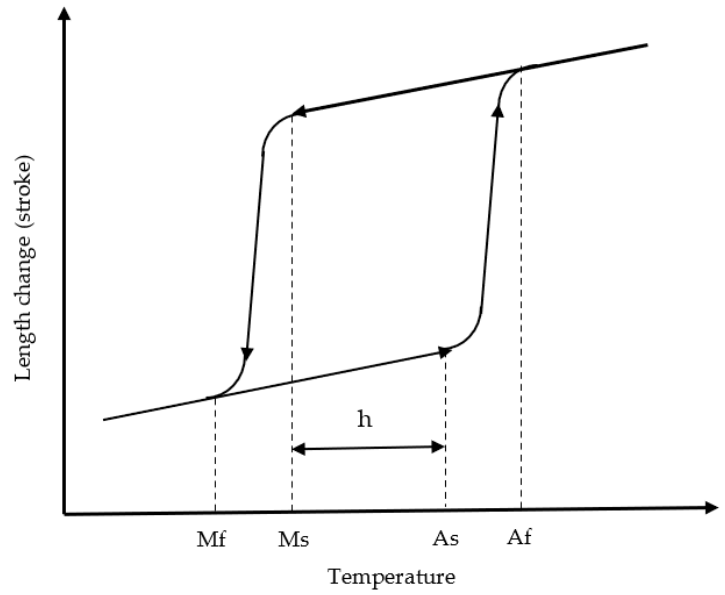
Figure 1. SMA length vs. temperature [23]. Table 1. Characteristic temperatures of SMAs.